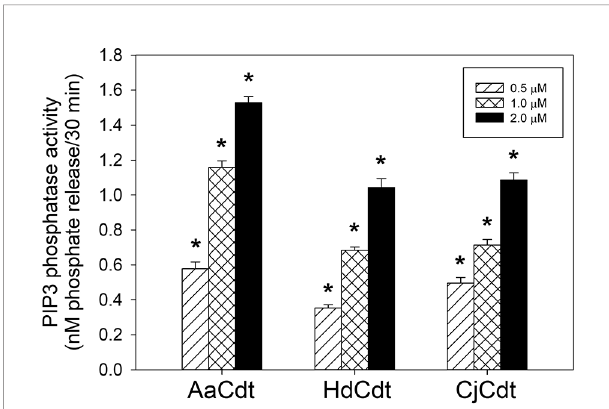
FIGURE 1 | Assessment of the HdCdtB and CjCdtB subunits for PIP3 phosphatase activity. Varying amounts of CdtB derived from HdCdt and CjCdt were assessed and compared to AaCdtB for their ability to hydrolyze PIP3 as described in Materials and Methods. The amount of phosphate release was measured using a malachite green binding assay. Data are plotted as phosphate release (nM/30min;mean ± SEM) vs protein concentration. Results are derived from three experiments each performed in triplicate; *indicates statistical signi fi cance (p < 0.01) relative to background control samples (0.05 nM/30 min) not receiving protein